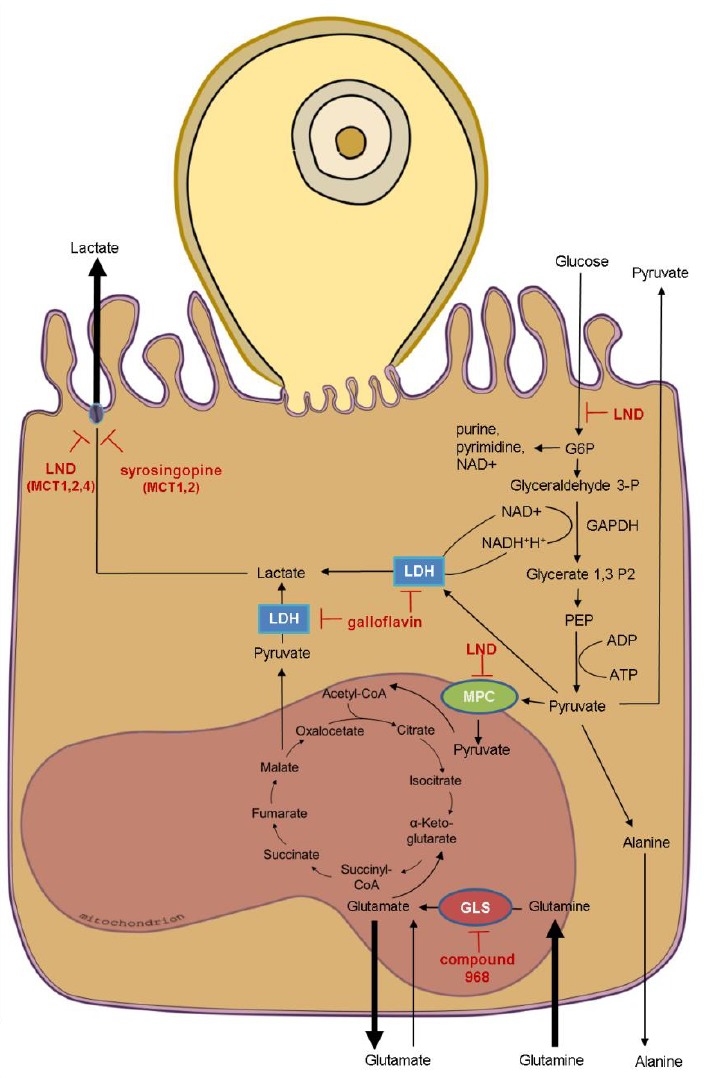
Figure 6. Schematic summary of the metabolic impact of C. parvum infection on HCT-8 cells cultivated in presence of 2 mM glutamine and 21% oxygen and targets of selected inhibitors. Bold arrows indicate impact on metabolic conversion rates of C. parvum -infected host cells (compare Figure 3). Based on C. parvum -induced alterations of host cell metabolism, the indicated metabolic inhibitors were selected to investigate their potential to inhibit C. parvum infection in HCT-8 cells. LND: lonidamine, MPC: mitochondrial pyruvate carrier, GLS: glutaminase, LDH: lactate dehydrogenase, MCT: monocarboxylate transporter.